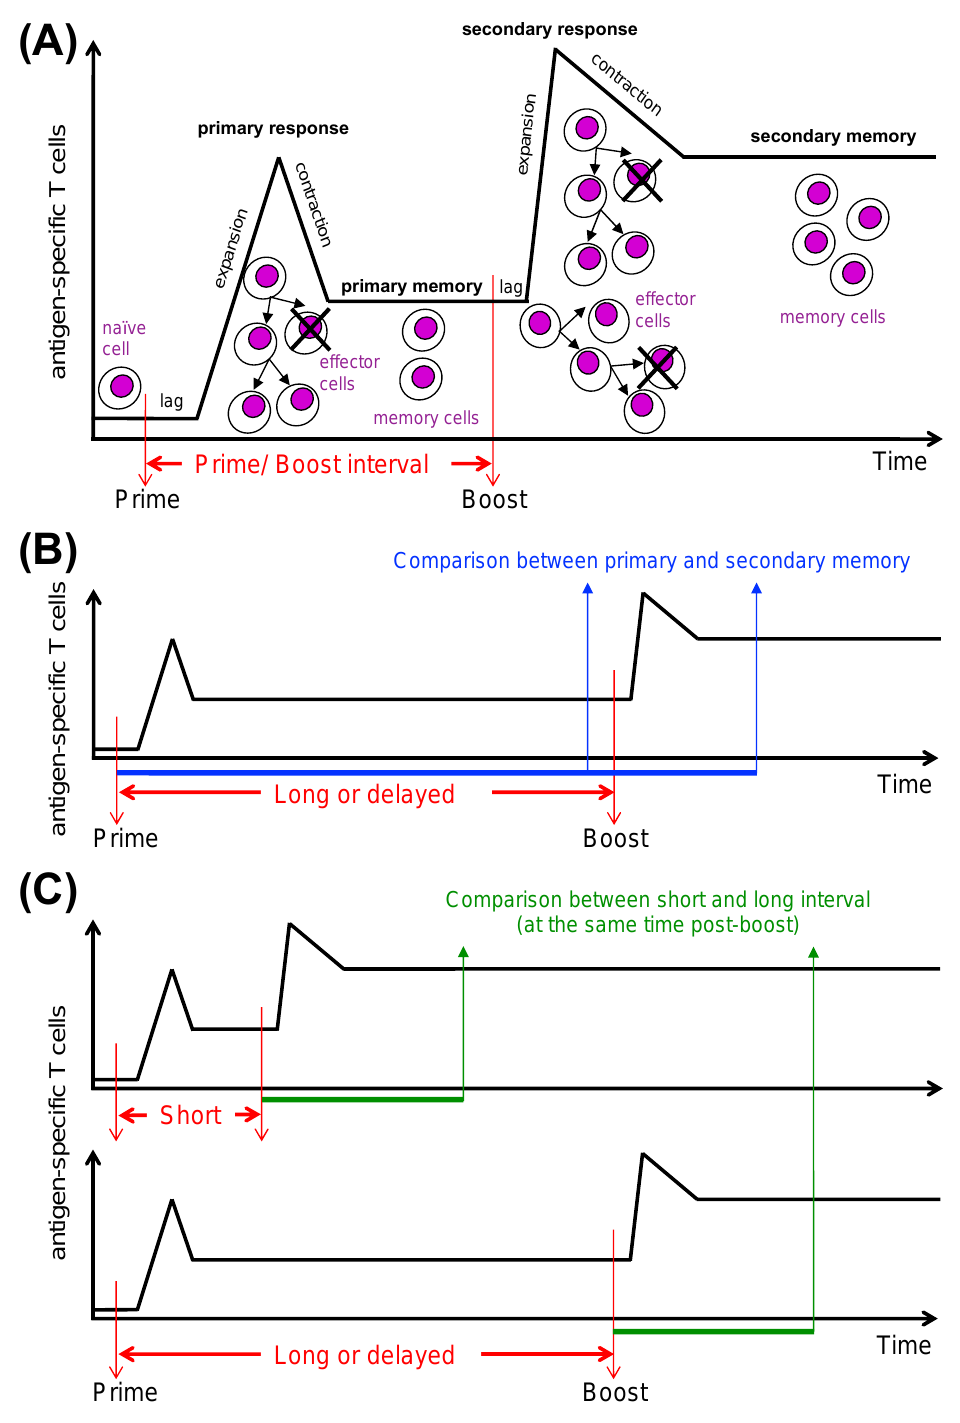
Figure 2. Antigen-specific T cell response by prime/boost vaccination. ( A ) Kinetics of response. After vaccine priming, the few naïve T cells that are specific for vaccine-carried antigens clonally expand and differentiate. The number of antigen-specific T cells rises gradually to detectable levels after a time lag, reaching a peak in some days. At the end of the acute phase of the primary response, most effector T cells die during the contraction phase, leaving behind a few memory T cells that remain in the primary memory phase. Upon vaccine boosting, these cells start proliferating after a shorter time lag and reach a higher peak compared with naïve cells. The contraction phase leaves behind a high number of memory T cells that persist in the secondary memory phase. ( B , C ) Prime/boost intervals of different time lengths: insightful comparisons. The panels represent T cell response to prime/boost vaccination according to either a “long” (also called “delayed”) or a “short” inter -dose interval regimen. Please note that, although it is possible that the two regimens result in different T cell responses, no changes